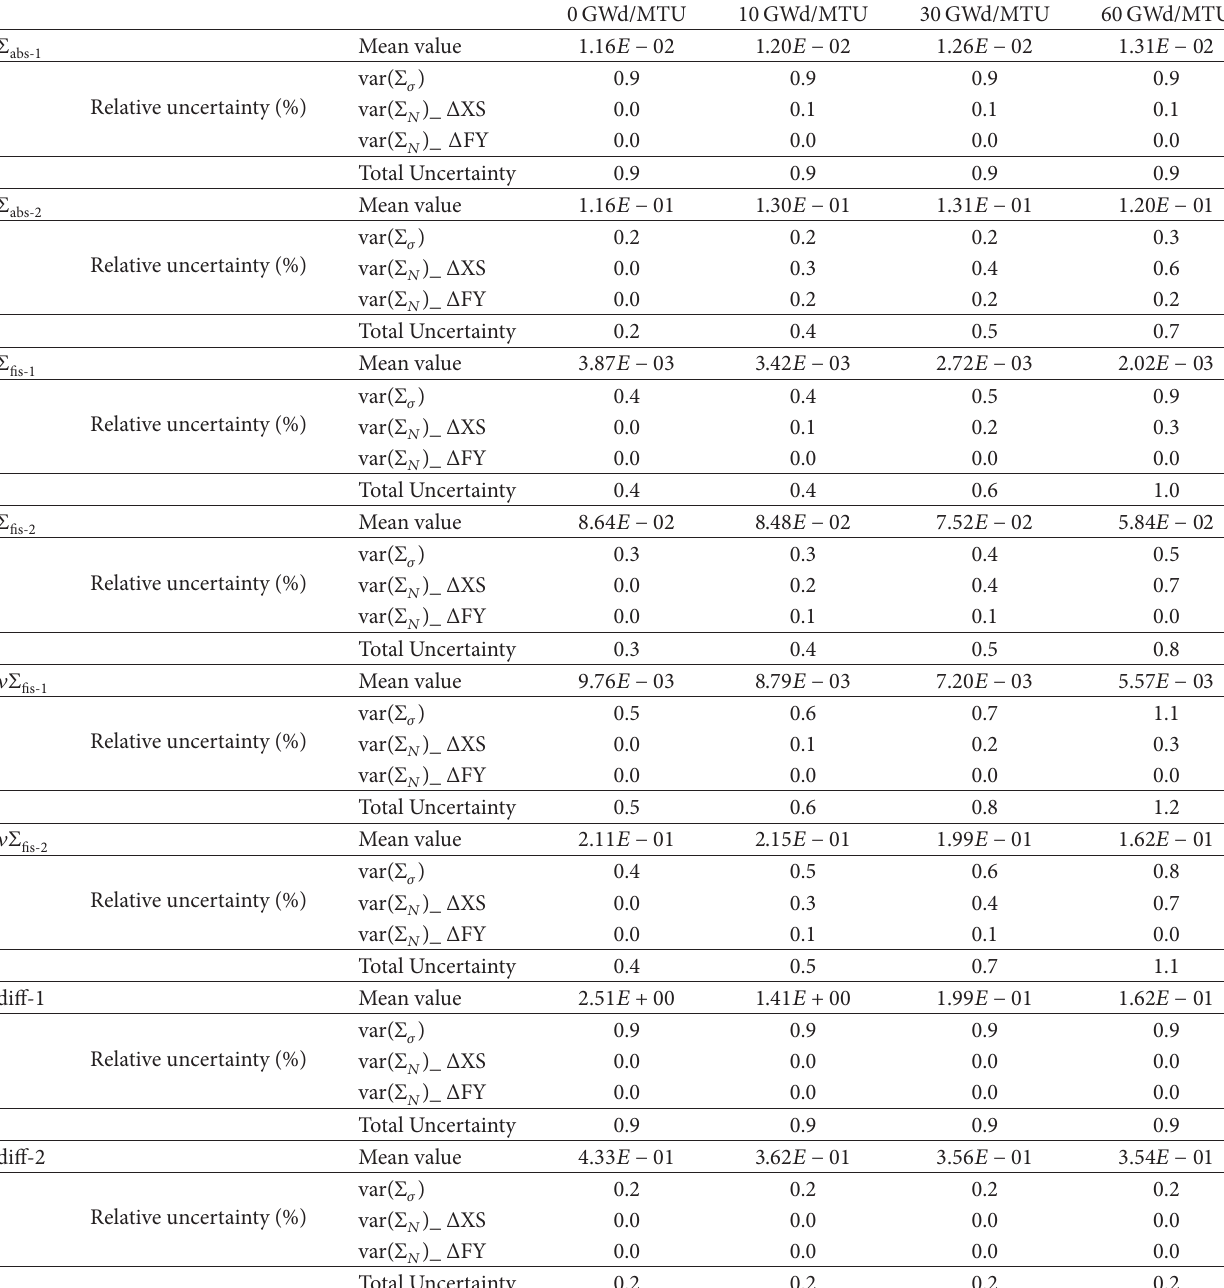
T 7: Uncertainty in two-group cross-section data. Cross-section uncertainties are taken from